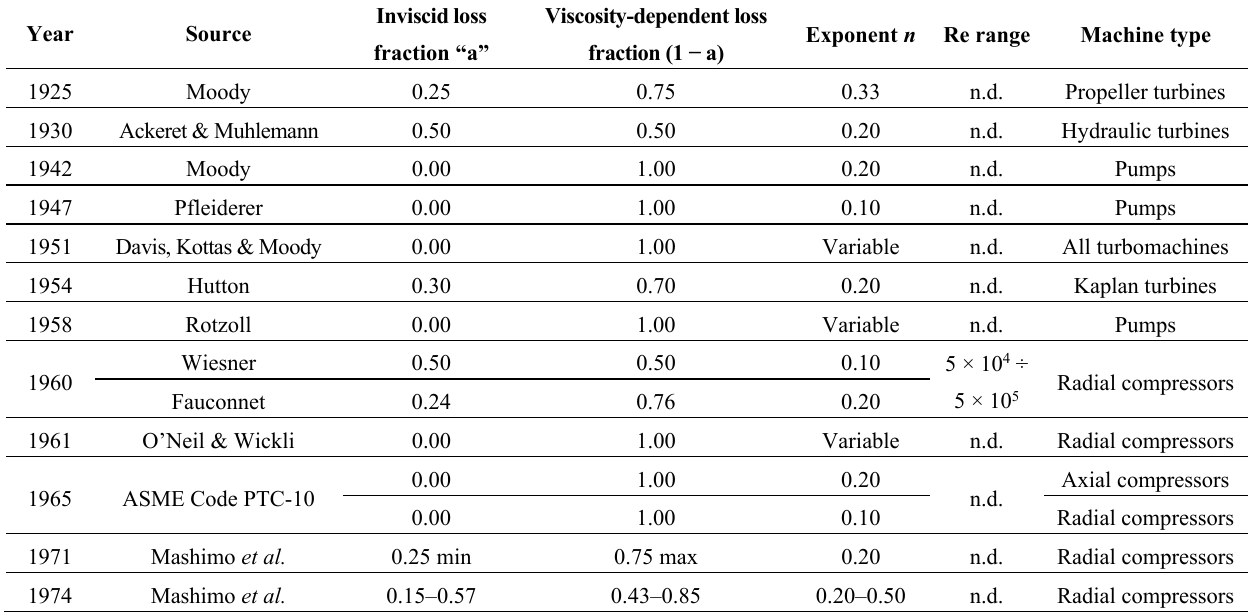
Table 1. Summary of the most popular efficiency correction equations